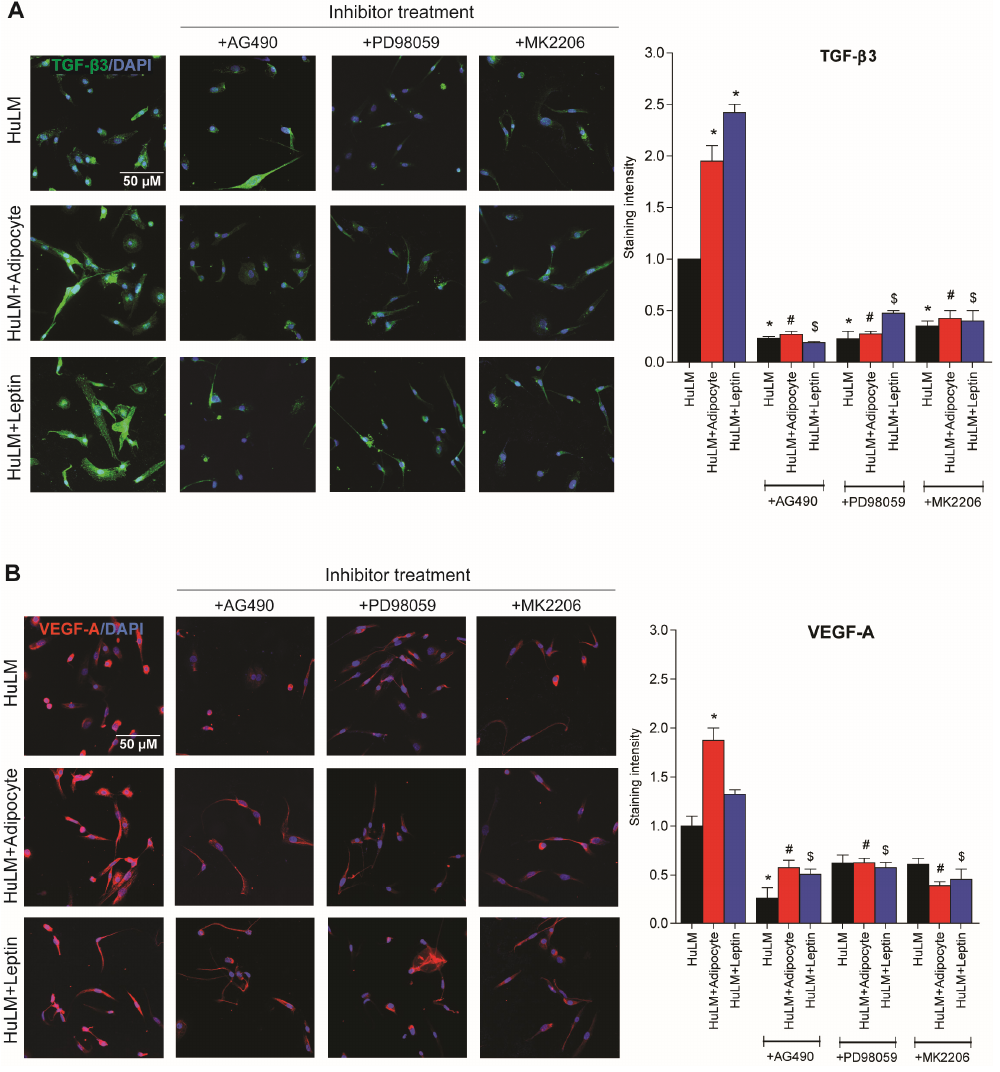
Figure 8. Effect of STAT3, ERK, and AKT inhibitor treatment in TGF- β 3 and VEGF-A expression. Immortalized human leiomyoma cells were cocultured with SW872 adipocyte cells for seven days and treated with leptin for 24 h. After seven days cocultured and 24 h leptin treatment, leiomyoma cells were treated for additional 24 h with the STAT3 inhibitor (AG490), the ERK inhibitor (PD98059), and the AKT inhibitor (MK2206). We performed immunocytochemistry to confirm the presence of ( A ) TGF- β 3 (green fluorescence), ( B ) VEGF-A (red fluorescence), and DAPI (blue fluorescence). All images were taken with a Zeiss AxioPlan 2 microscope system (20× magnification). Scale bar, 50 μ m. Images were measured and quantified using ImageJ. *, p < 0.05 vs. the single cell type culture; #, p < 0.05 vs. coculture; $, p < 0.05 vs. leptin treated cells.